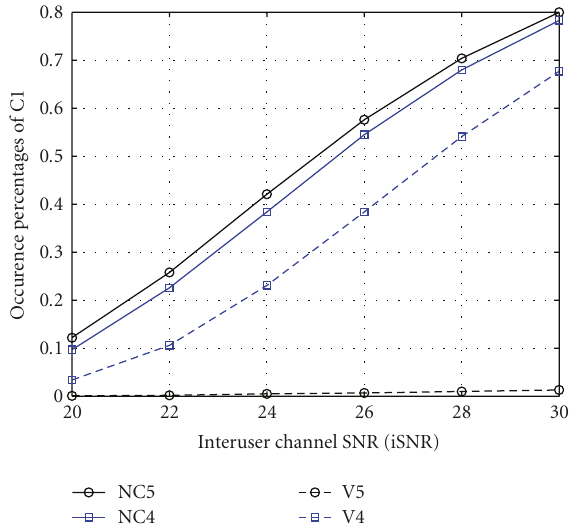
Figure 13: Occurrence percentages of C1 for 8PSK codes.